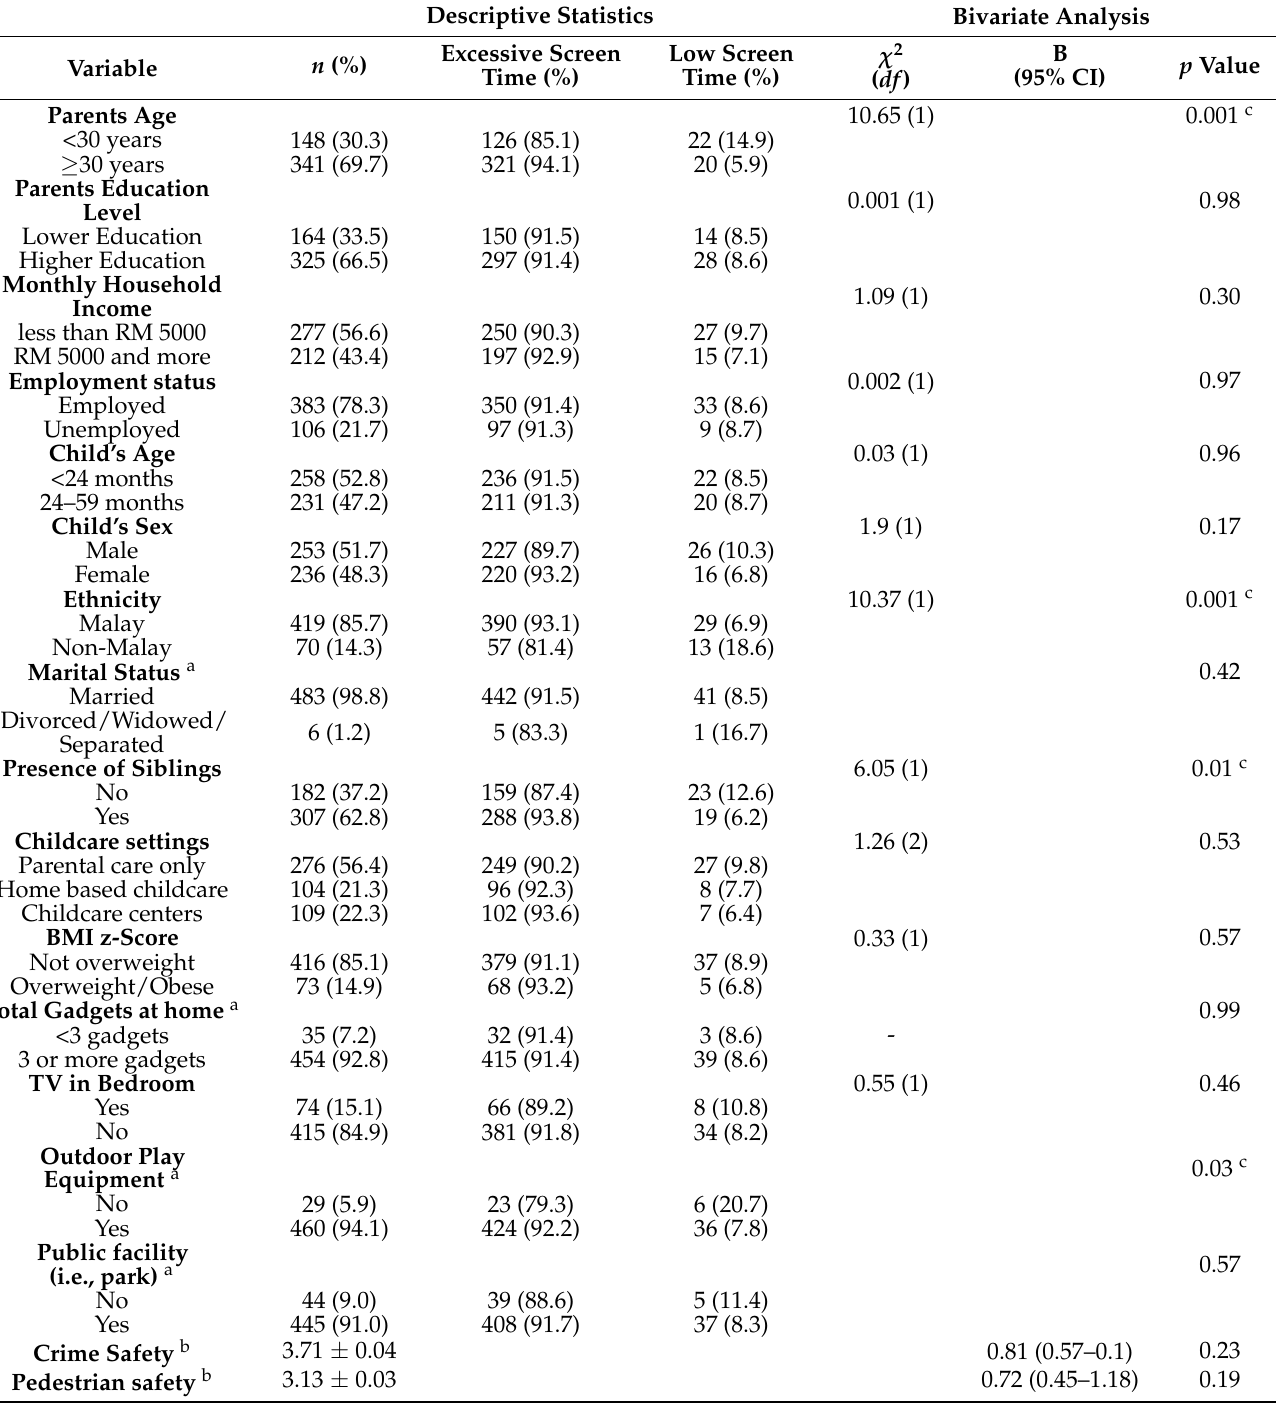
Table 1. Association between sociodemographic, household and neighbourhood characteristics and children screen time ( n =